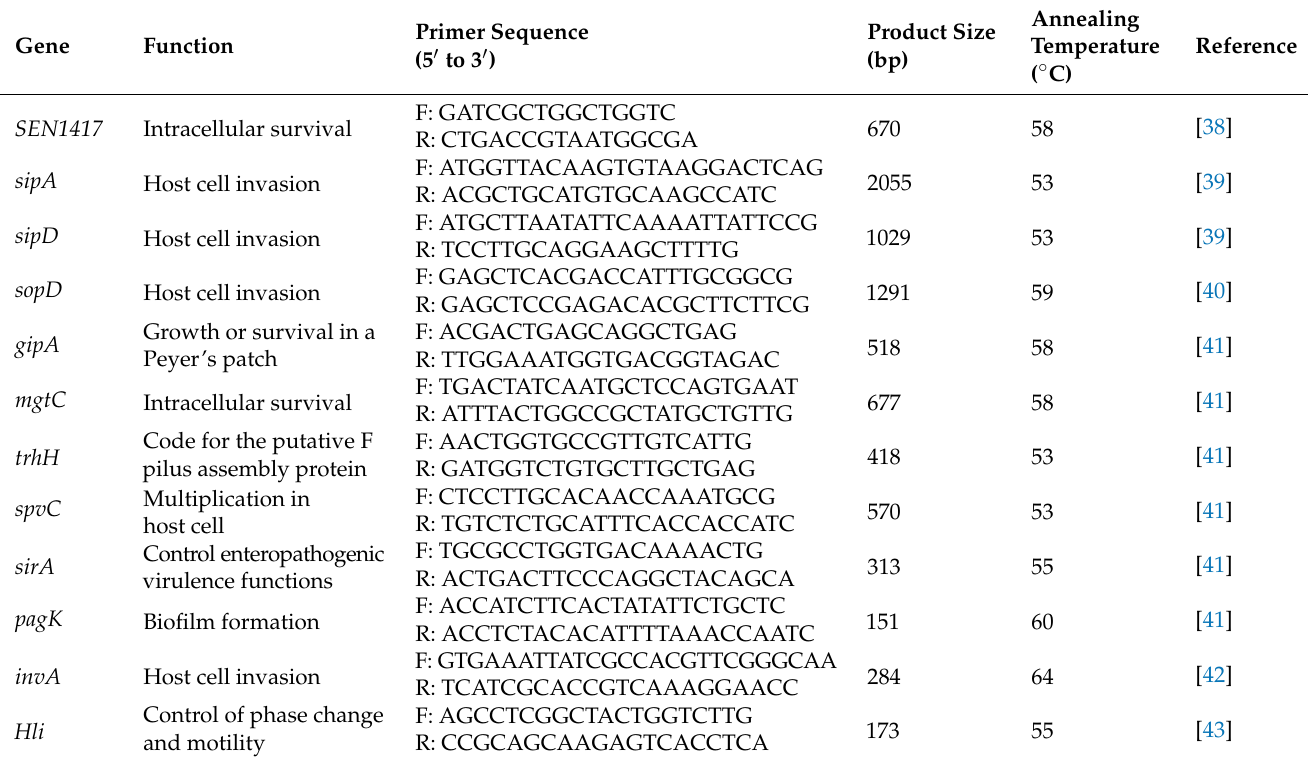
Table 3. Primers of Salmonella for virulence genes targeted in the present study.